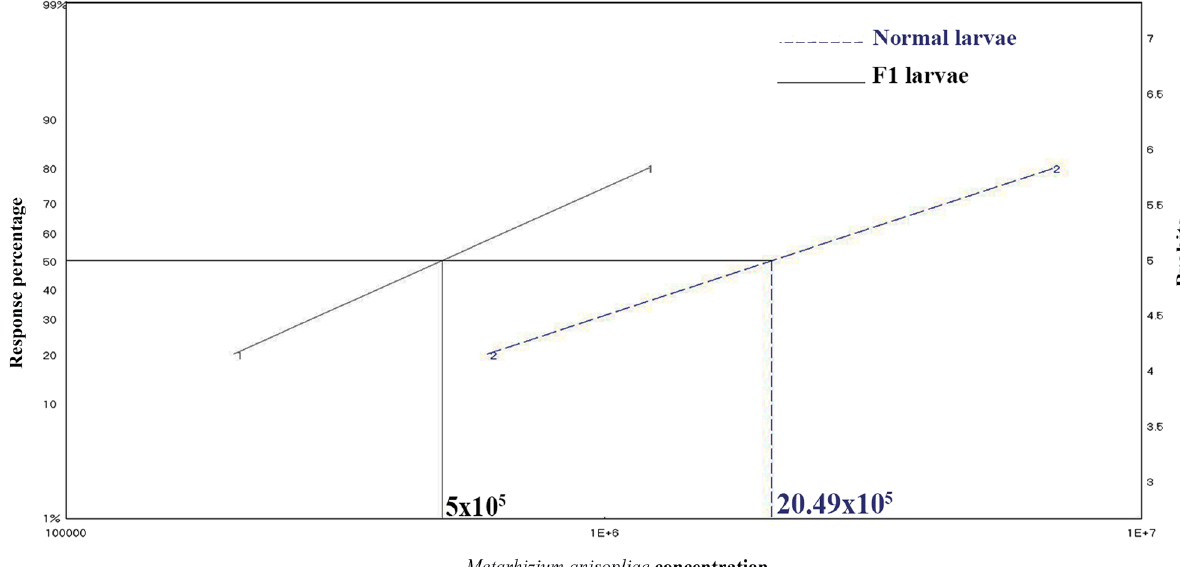
Fig. 3 LC 50 values of Metarhizium anisopliae (Bio Magic) after